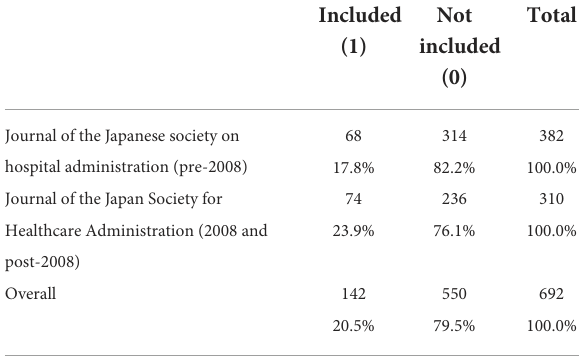
TABLE 2 Target words included or not included pre- and post-2008 in the